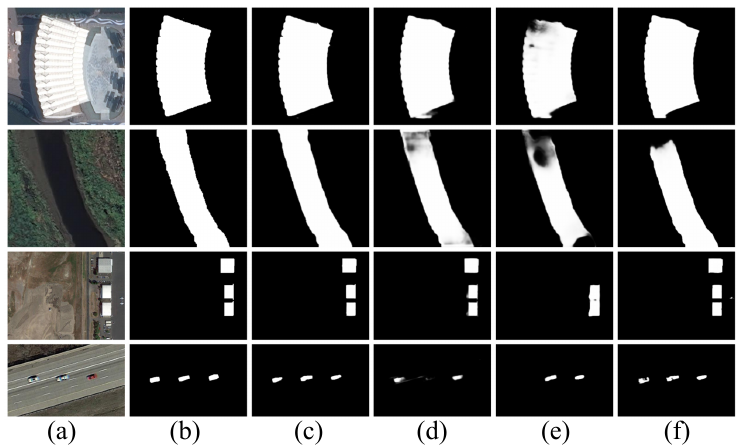
Figure 5. Qualitative Visual results of ablation analysis. ( a ): RGB, ( b ): GT, ( c ): Ours, ( d ): w/o Edge, ( e ): w/o Fusion, ( f ): w/o